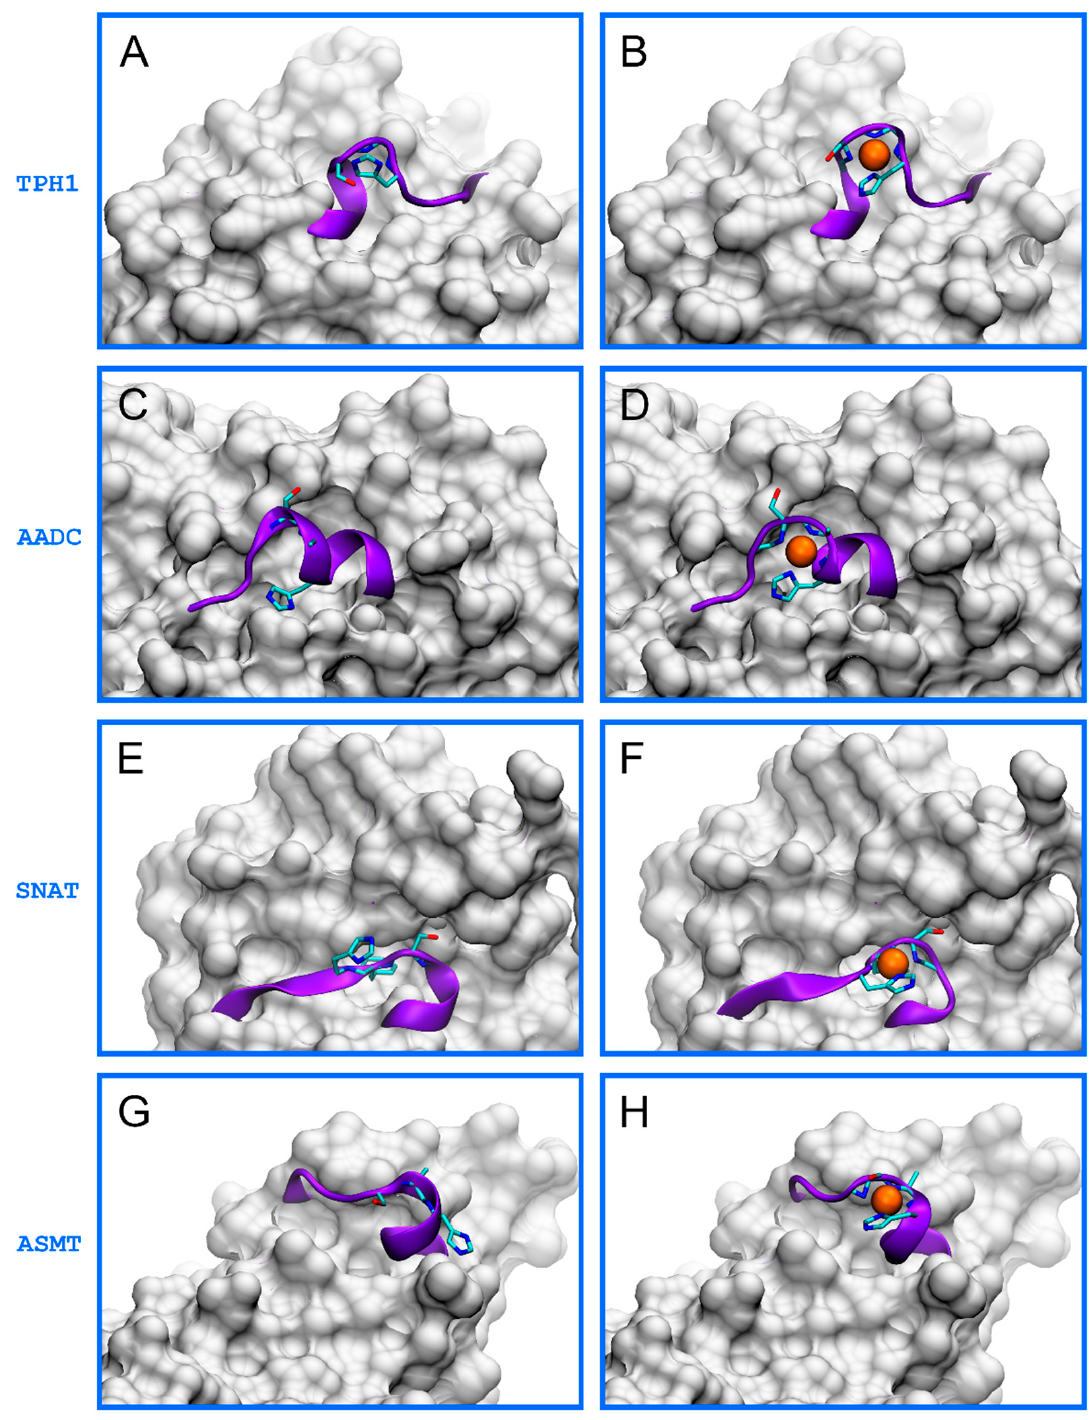
Figure 1. The structures of human enzymes from the melatonin synthesis pathway, both original apo-proteins (left) and modeled Ni(II)-bound forms (right). Presented are tryptophan 5-hydroxylase 1 (TPH1, PDB: 5L01, ( A , B )), aromatic- L -amino-acid decarboxylase (AADC, PDB: 3RBF, ( C , D )), serotonin N -acetyltransferase (SNAT, AlphaFold: AF-Q16613-F1, ( E , F )), and acetylserotonin O -methyltransferase (ASMT, PDB: 4A6E, ( G , H )). The nonapeptide fragments studied in this work are depicted as violet strands, Ser/Thr-Xaa-His fragments are shown as licorice, and Ni(II) ions are shown as orange spheres. The remaining parts of the proteins are represented by gray surfaces.